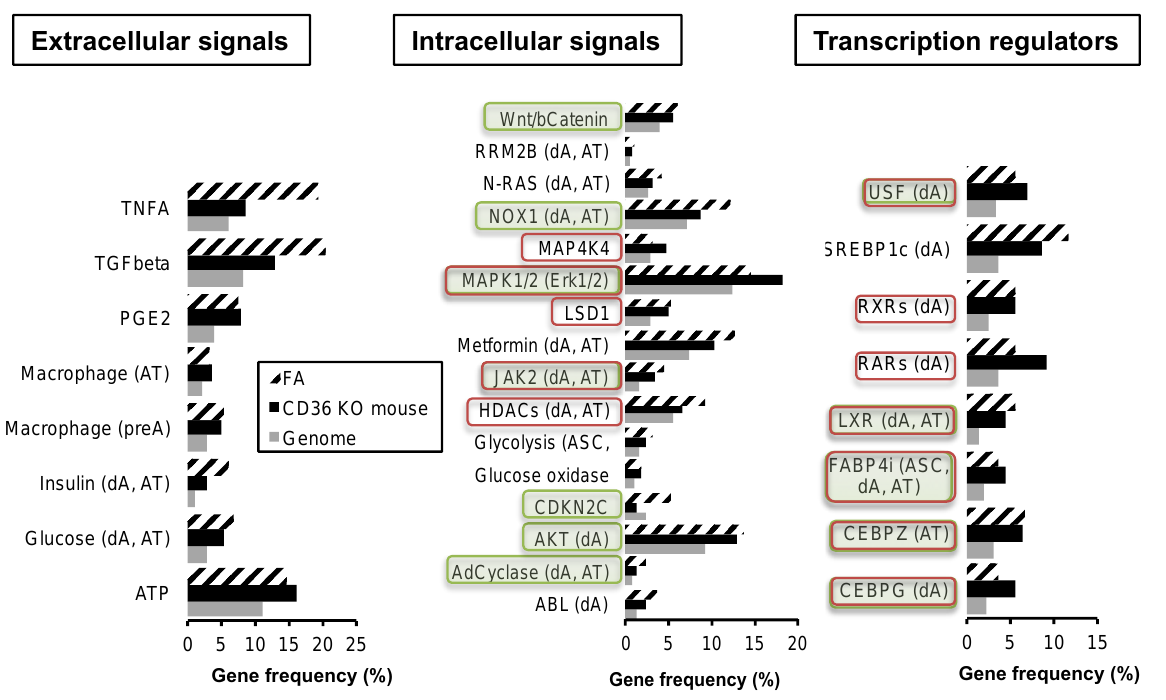
Figure 2. Transcriptional regulation pathways commonly regulated in FAT/CD36 knock-out mice and by fatty acids. Pathways over-represented in adipose cell lineage are reported as ASC (adipose stem cells), AT (adipose tissue), and dA (in vitro differentiated adipocytes). Pathways significantly over-represented in the gene dataset regulated by intracellular FABP4i are indicated in green, in that of extracellular FABP4 in red. Only significantly over-represented pathways in comparison to the genome dataset are reported (z-score confidence levels > 95%).